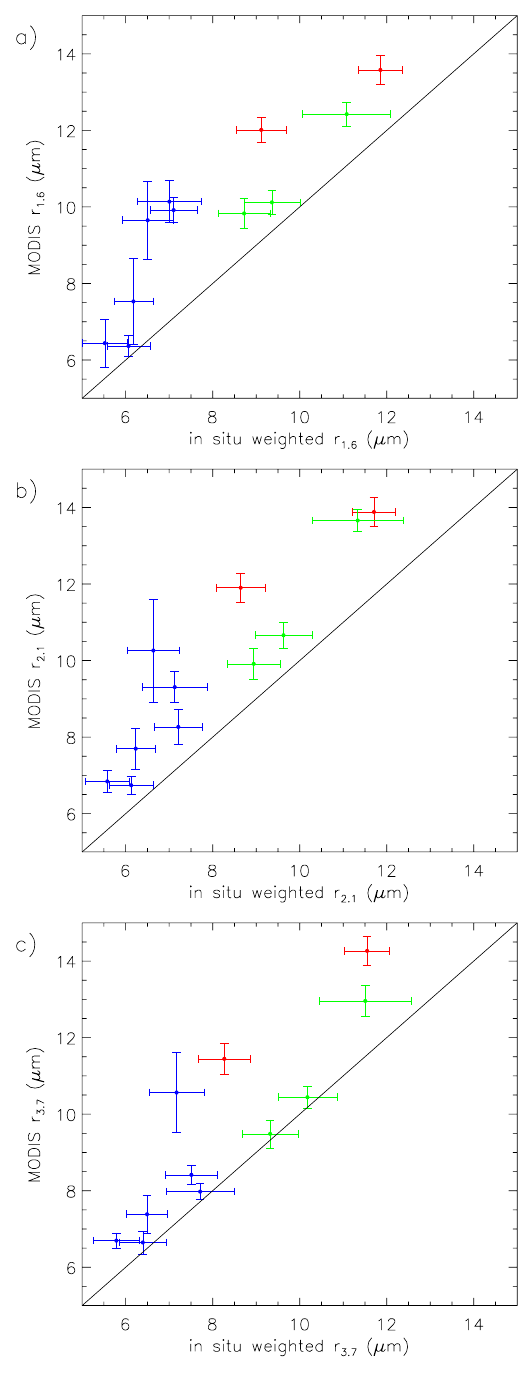
Fig. 7. Same as figure 3 except the in situ r e is calculated by synthe- sising a measurement from the full vertical profile and performing a theoretical